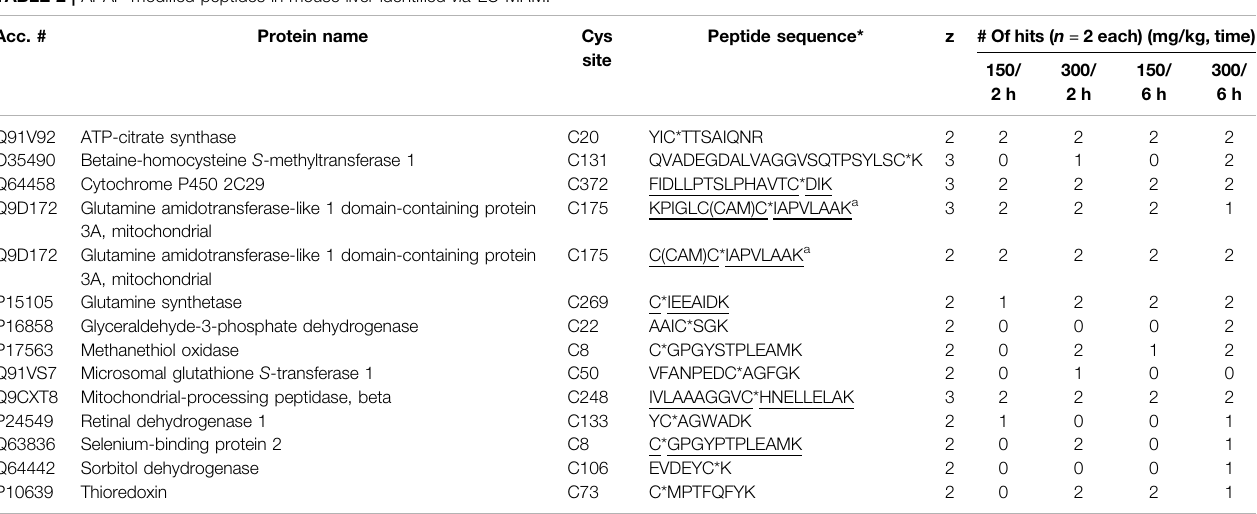
TABLE 2 | APAP-modi fi ed peptides in mouse liver identi fi ed via LC-MRM. Acc.